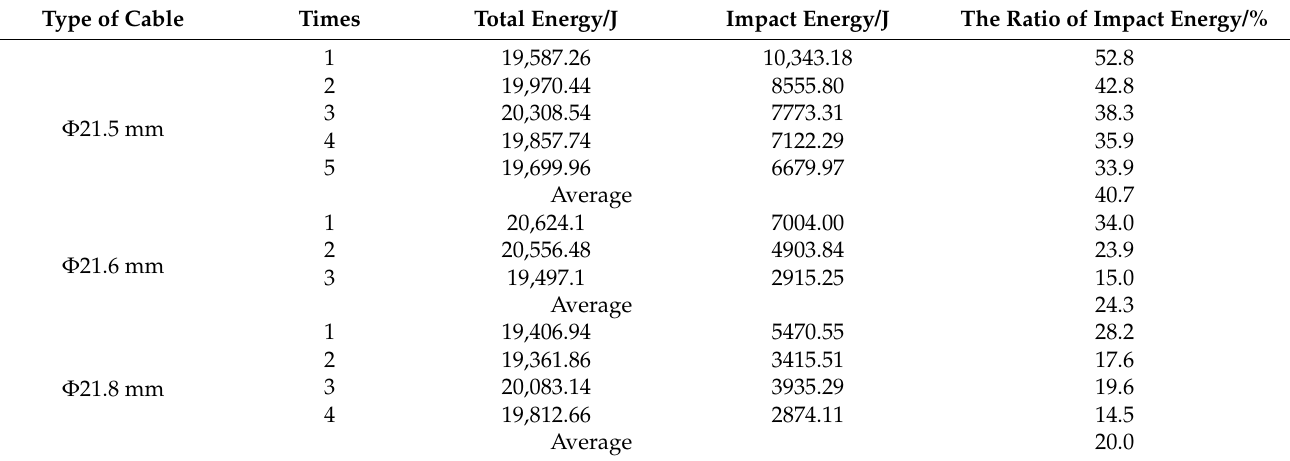
Table 6. The proportion of impact energy to total impact energy.